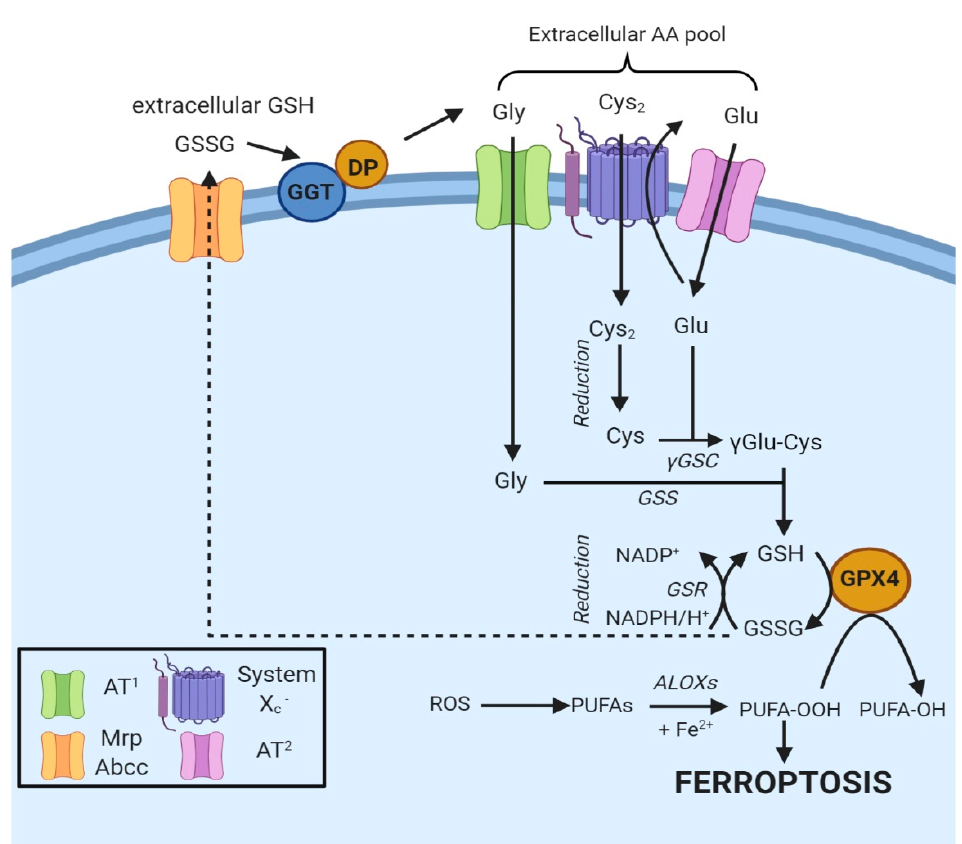
Figure 2. Oxidized GSH (GSSG) is exported from the cell via the MRP/ABCC transporter and hydrolyzed by GGT and dipeptidase to Gly, Glu and Cys 2 , thus contributing to the extracellular amino γ -glutamylcysteine acid pool. Specific amino acid transporters (AT1 and AT2) internalize Gly and Glu, while Cys 2 is taken up by system X c- [11]. Once in the cell, Cys 2 is reduced to Cys and combined with Glu to generate γ Glu-Cys [11]. The addition of Gly to the dipeptide catalyzes the formation of GSH, a cofactor of GPX4. The box on the bottom left indicates the proteins involved.